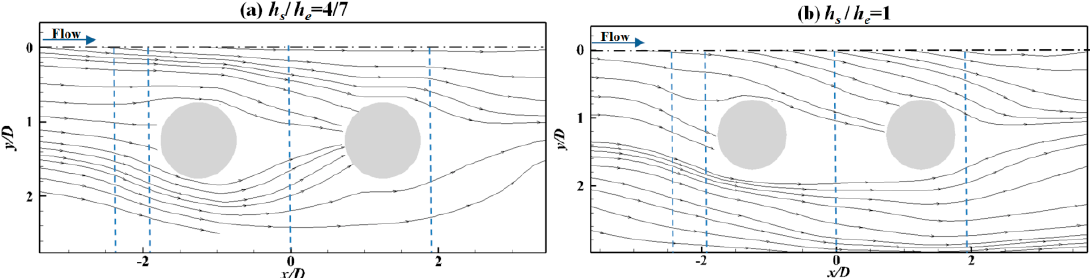
Figure 14. Two-dimensional streamlines at the horizontal planes of z / D = 0 for ( a ) h s / h e = 4/7 and ( b ) h s / h e = 1.